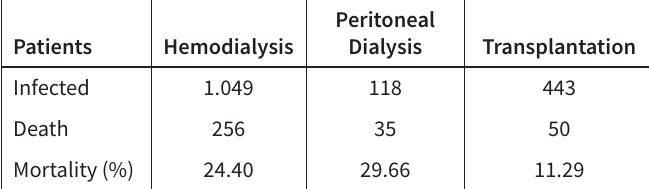
Table 3. Mortality Rate of Kidney Replacement Therapy Patients with Coronavirus Disease 2019 Diagnosis by